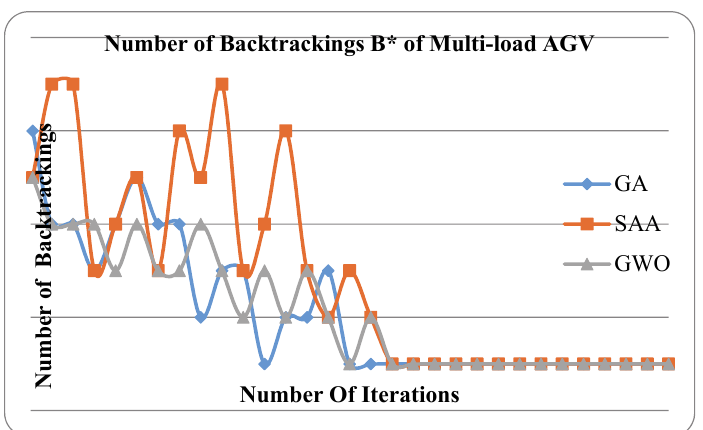
Fig. 4. Total distance travel (D*) by AGV